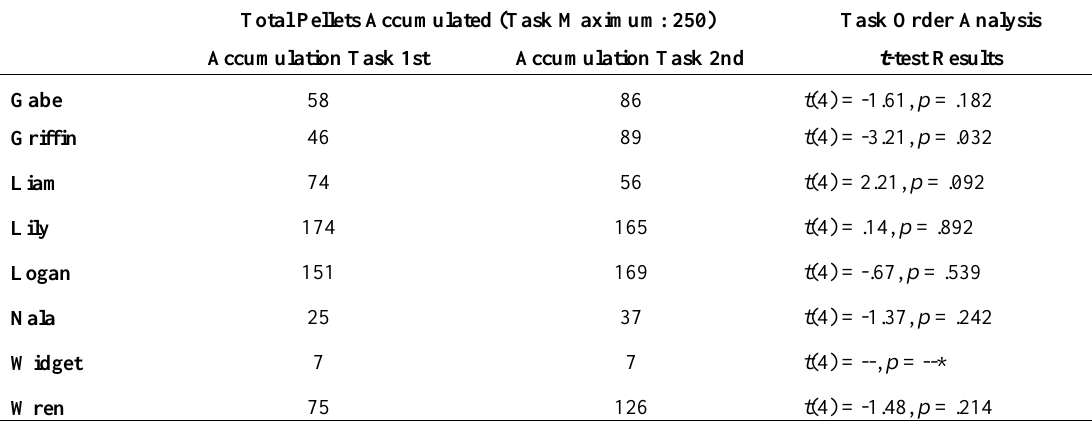
Accumulation Test Performance from Experiment 2 when the Task was Presented First (Prior to Exchange) Versus Second (After Exchange) Total Pellets Accumulated (Task Maximum: 250) Task Order Analysis Accumulation Task 1st Accumulation Task 2nd t -test Results